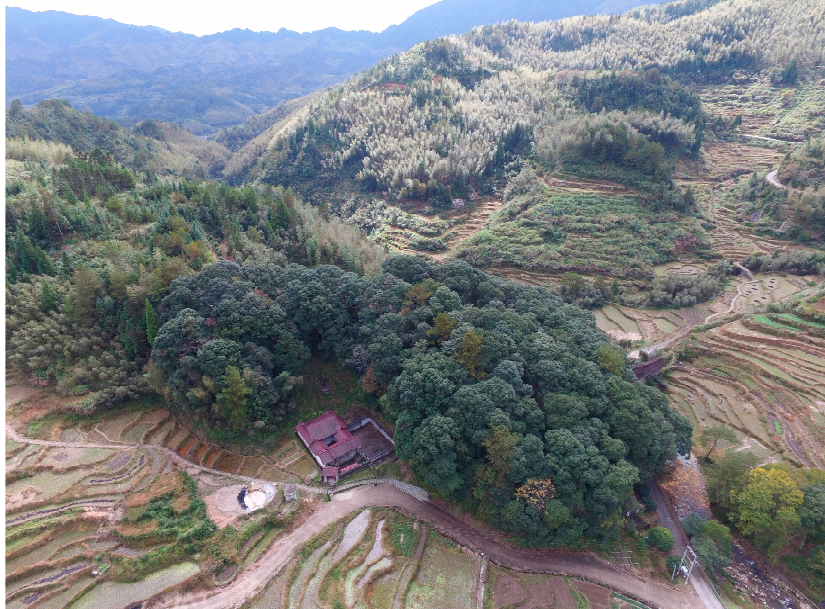
Figure 9. The same shuikou forest in Sanjiaoqiu village taken from slightly upstream and showing an ancestral temple nestled along the edge of the forest. (Drone photo by the author, 2018)